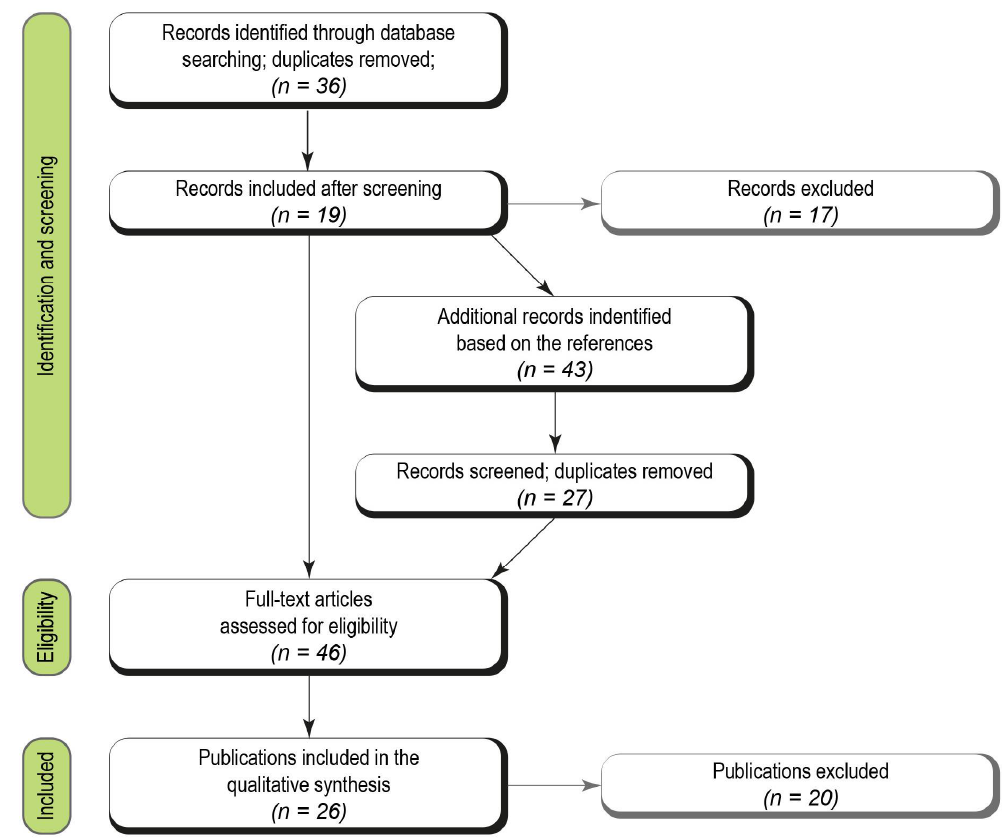
Figure 1. Flow diagram of the literature search process, showing the number of included and excluded studies at each stage according to the PRISMA guidelines [16].